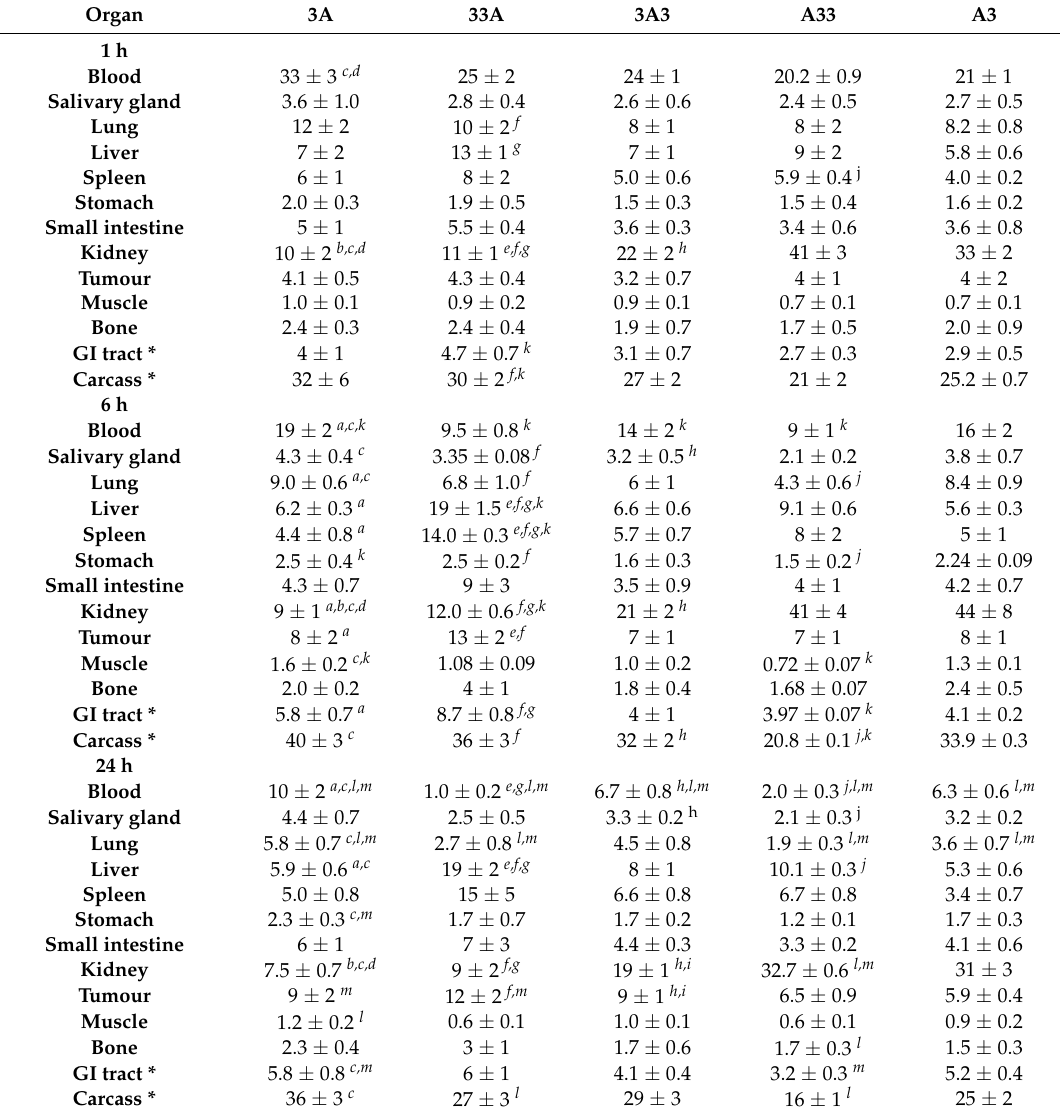
Table 3. Biodistribution of 111 In–labelled ABD-fused anti-HER3 affibody molecules in female BALB/c-nu/nu mice with BxPC-3 xenografts 1, 6, and 24 h after intravenous injection. The measured radioactivity of different organs is expressed as % of injected dose per gram tissue (%ID/g), and presented as an average value from four animals ± SD. GI tract: gastrointestinal